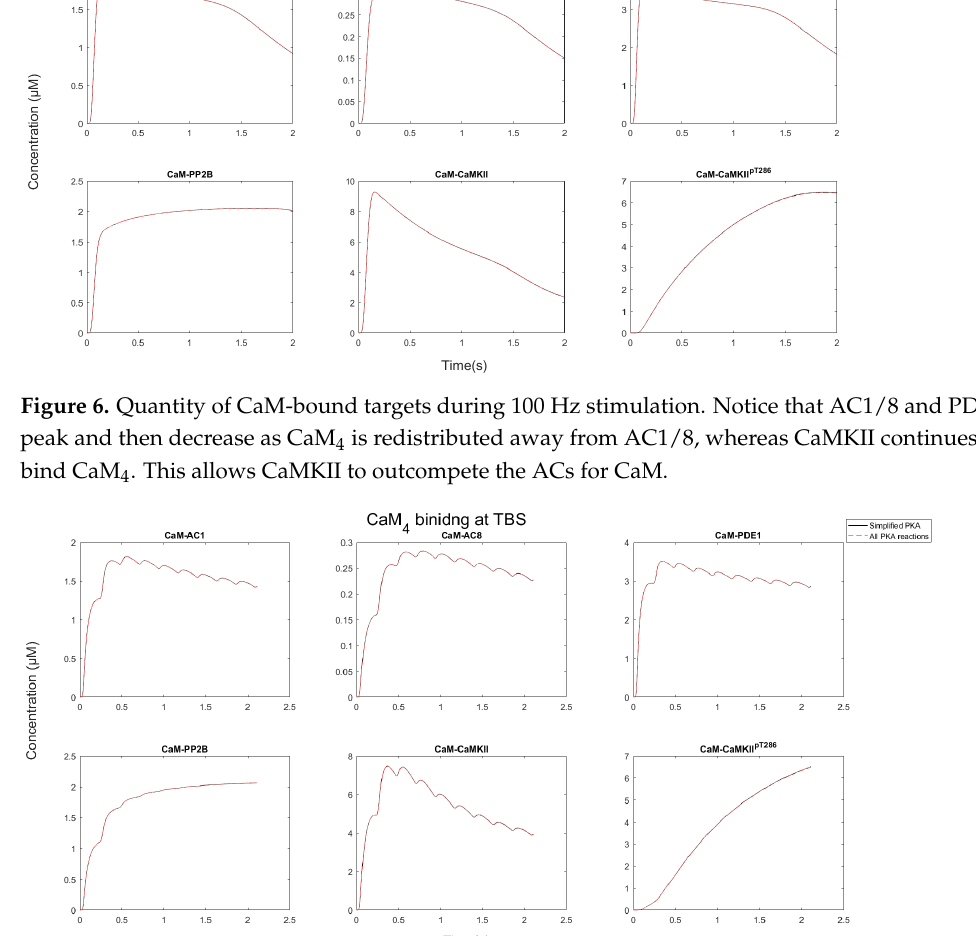
Figure 7. CaM 4 binding to its partners during a TBS train. Like 100 Hz and 10 Hz, AC1, AC8, and PDE1 reduce in concentration as phosphorylated CaMKII increases. The timing of each of the 10 epochs is evident, especially for the bound portions of AC1, AC8, and PDE1 as evidenced by their peaks. Then between each peak, they dissociate from CaM 4 . The bound portions of PP2B and phosphorylated CaMKII are not subject to dissociation due to the high affinity for CaM 4 . PP2B approaches a peak concentration and then plateaus. The phosphorylated CaMKII increases linearly independent of epochs. Perhaps the function of spacing epochs is to allow for a redistribution of CaM 4 between each epoch.